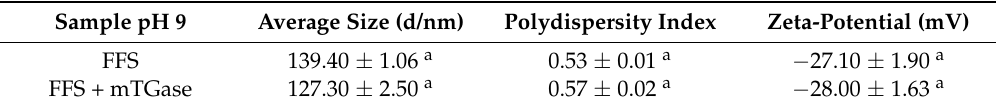
Figure 2. Panel A-SDS-PAGE of untreated (lane 1) and mTGase-treated (lane 2) FFSs. Panel B-SDS- PAGE of solubilized films cast in the absence (lane 1) and presence (lane 2) of mTGase. St, Molecular weight standards, Bio-Rad. ( A ) FFSs; ( B ) FILMS.